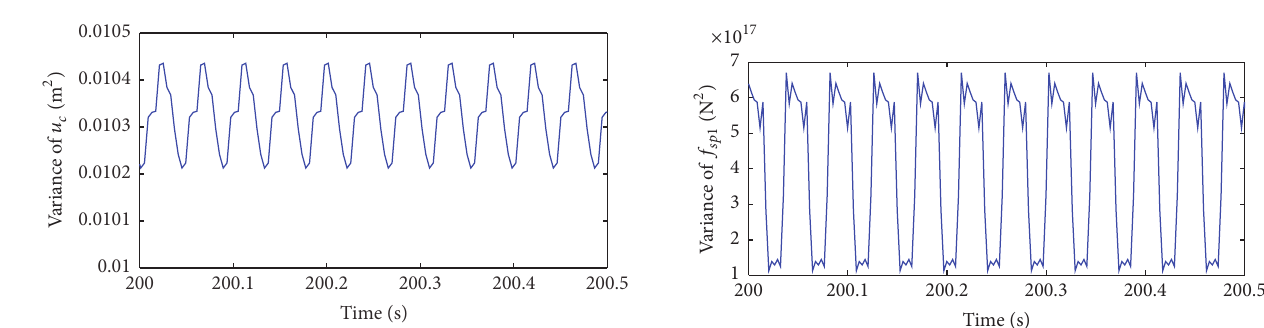
𝑠 − 𝑝 mesh. 𝑠𝑝1 , meshing force at 1st